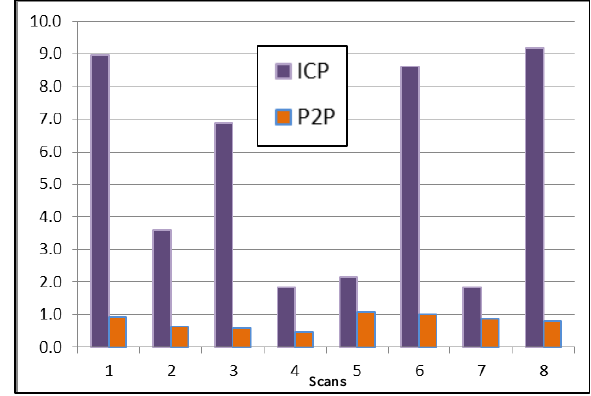
Figure 6. Misclosure RMSE (mm) for the eight scans.